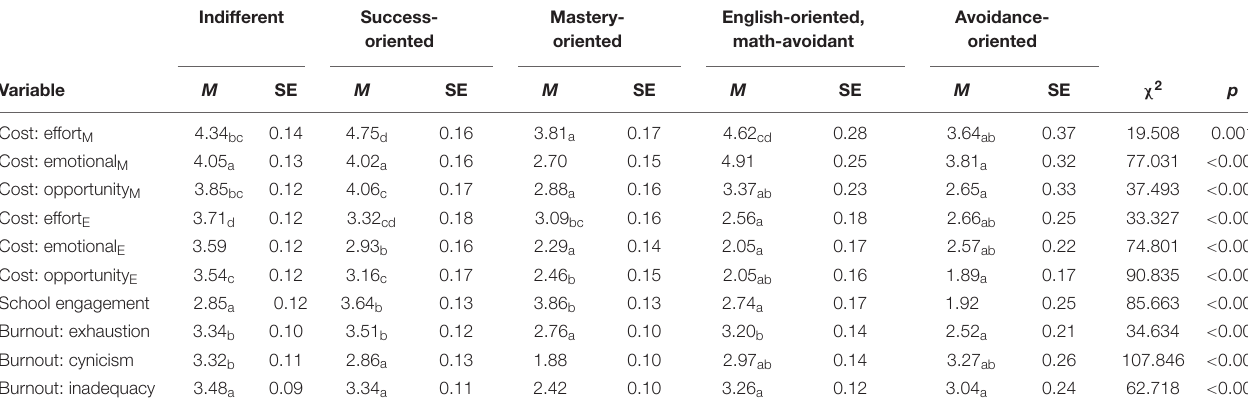
TABLE 5 | Mean differences in subject-specific cost and academic well-being between the latent goal orientation profiles based on the Bolck–Croon–Hagenaars (BCH) method. Indifferent Success- Mastery- English-oriented, oriented oriented